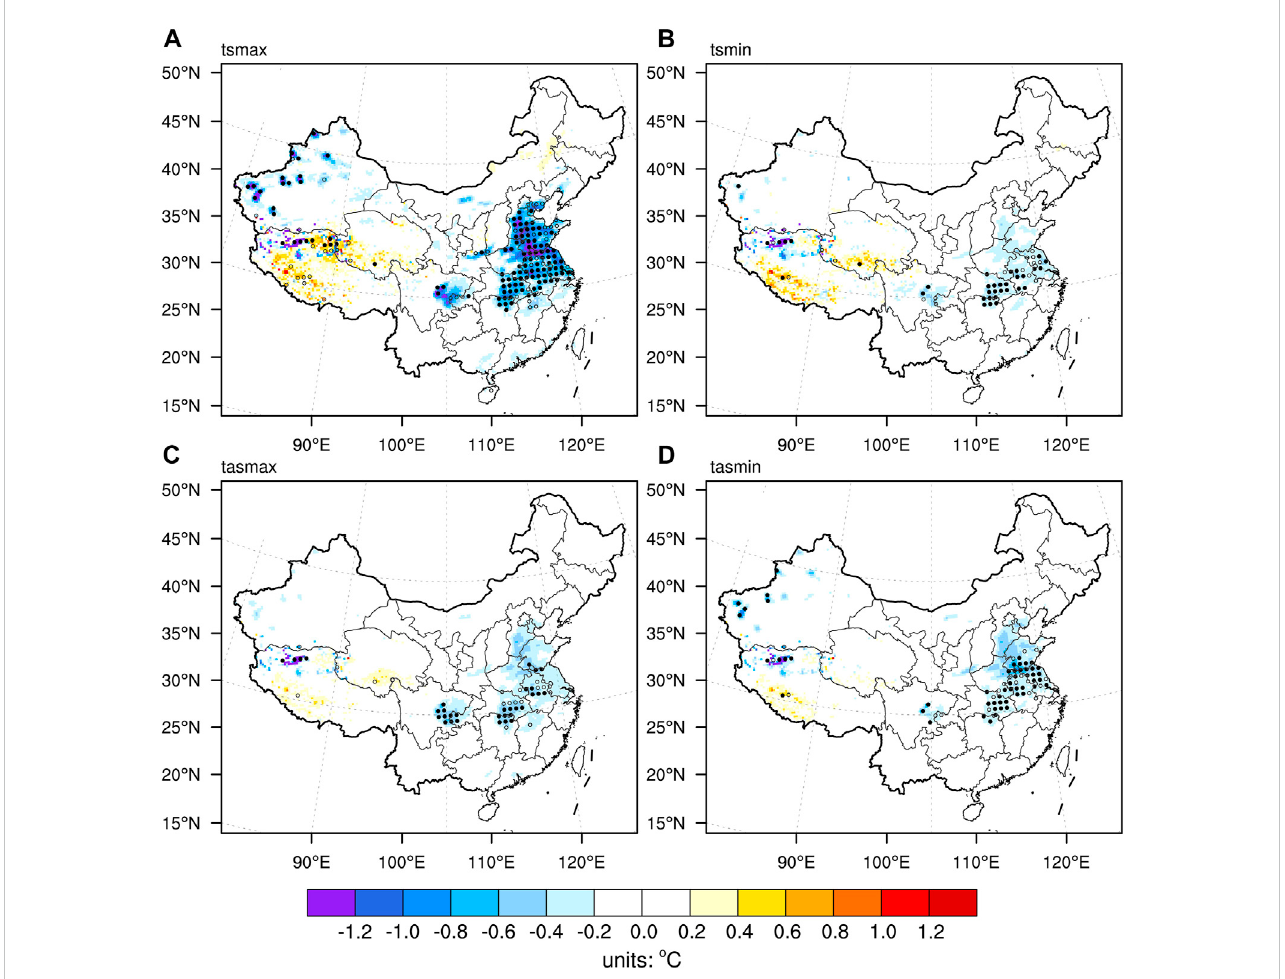
FIGURE 3 Irrigation-induced changes in annual mean surface temperature variables (units: ° C): (A) maximum land surface temperature ( Tsmax ), (B) minimum land surfacetemperature( Tsmin ), (C) maximum2 mairtemperature( Tmax )and (D) minimum2 mairtemperature( Tmin ).Notethatthesolid(hollow)blackdotsin the fi gures indicate a greater than “ strong ” ( “ moderate ” ) degree of consistency among the results of the ensemble members (i.e., statistically signi fi cant changes at the 90% con fi dence level are observed for 3 (2) out of four simulation